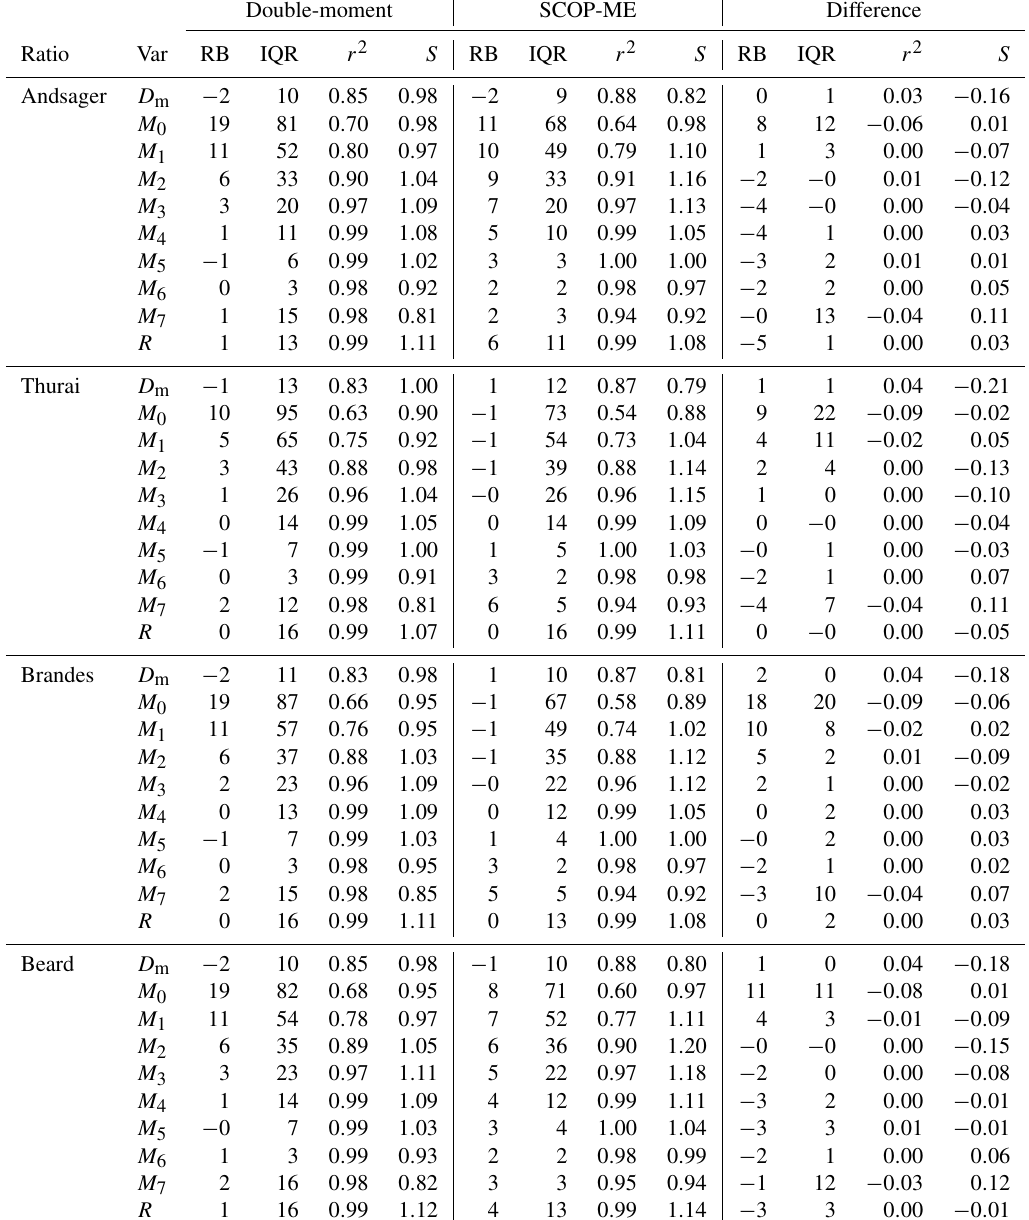
Table A1. Comparison of double-moment method to SCOP-ME results on all Parsivel data in the HyMeX data set by axis ratio function (Ratio). RB (%) is median relative bias, IQR (%pts) is interquartile range of relative bias (%points), r 2 is squared correlation coefficient. S is the slope on measured vs. reconstructed regression. Difference is the difference in absolute values for RB and IQR and the difference in deviation from unity for r 2 and slope. A negative difference shows that the double-moment method improved on SCOP-ME’s